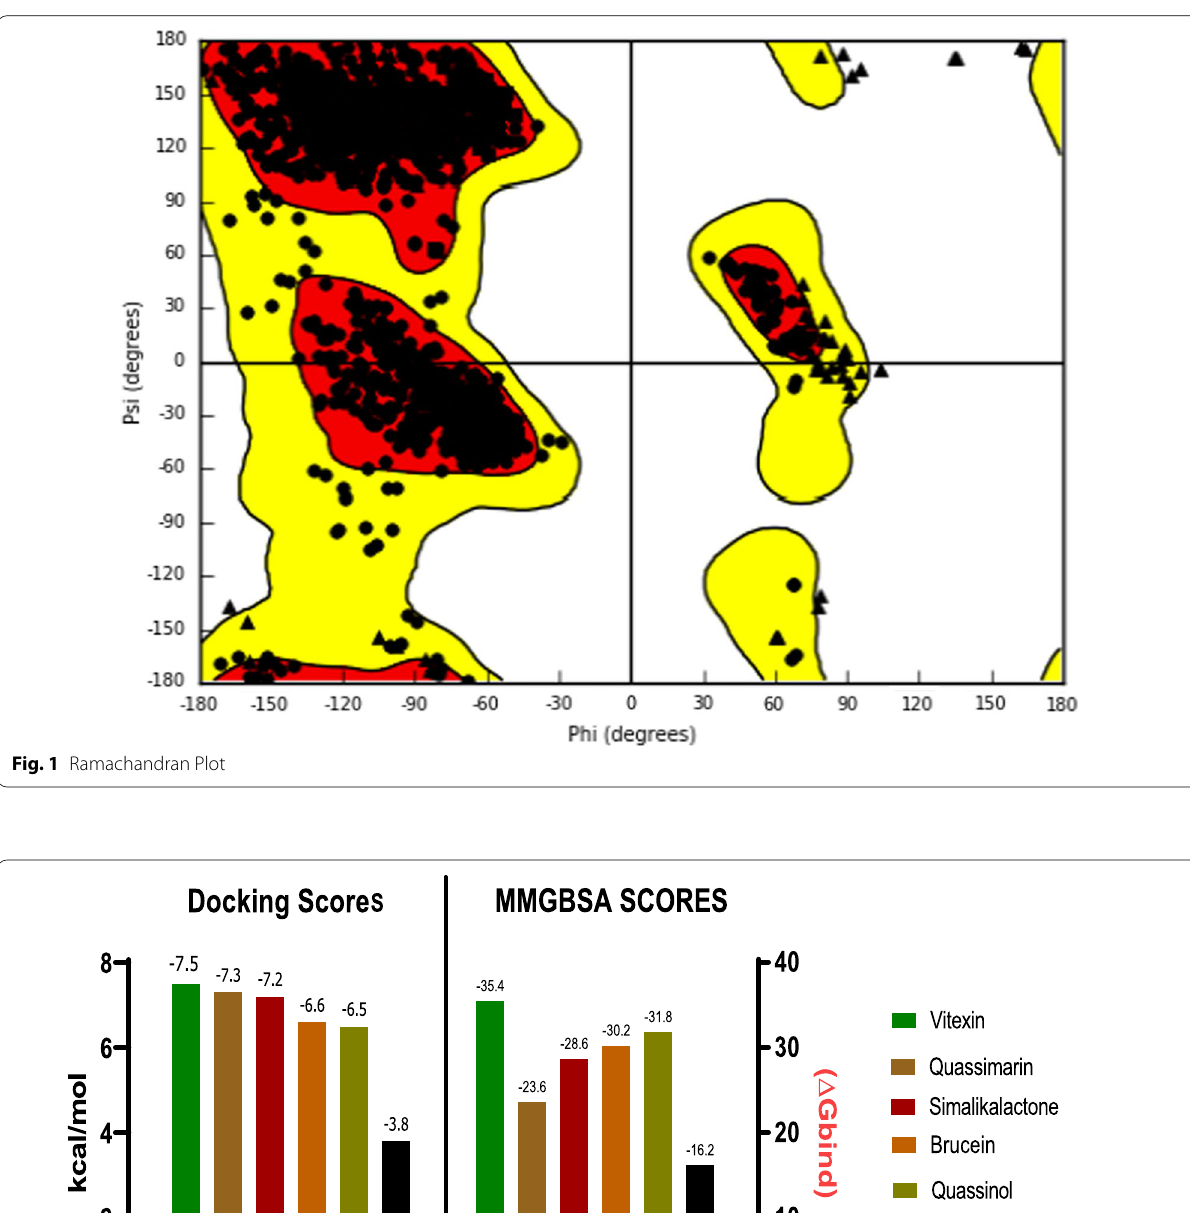
library of compounds in this study to reveal the molecu- lar interaction, inhibitory potential, and binding pose of compounds from the Quassia amara plant against DPP- IV. The findings indicate that five compounds,